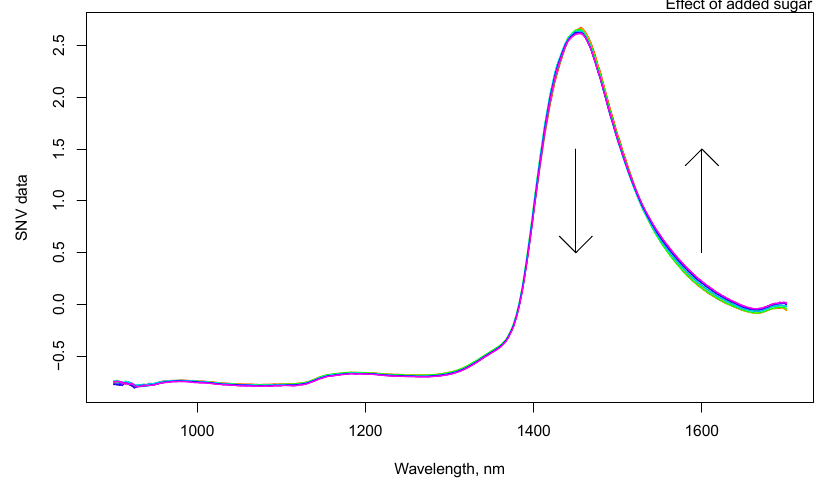
Figure 3. Normalized spectral readings in 900–1700 nm and their change with water dilution ( upper ) and added sugar ( lower ). The arrows represent the direction of the increasing adulteration.